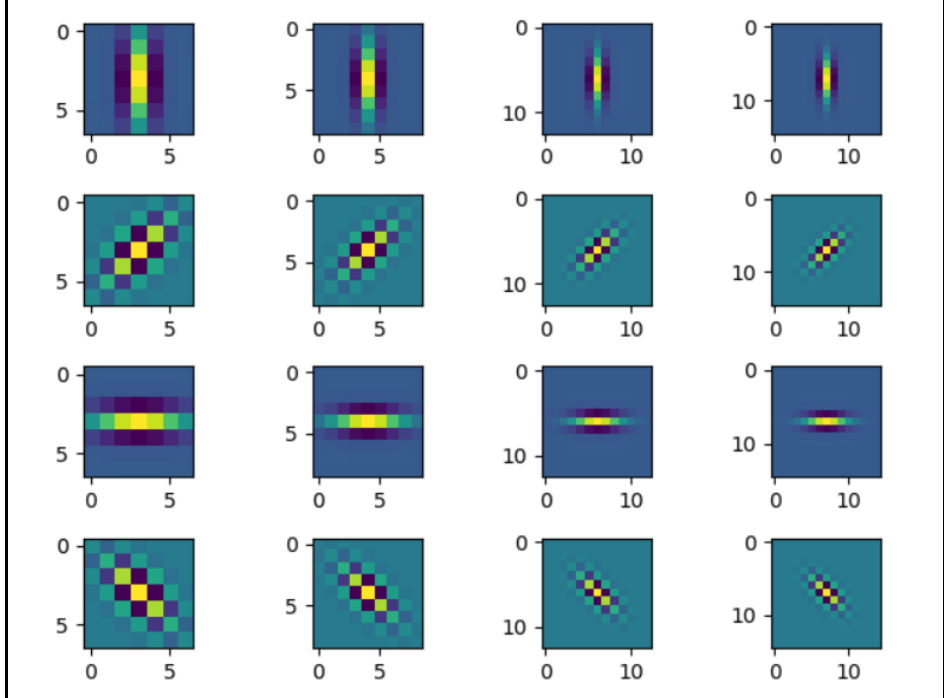
Figure 6. Schematic diagram of the choice of the scale and orientation of the Gabor filter.